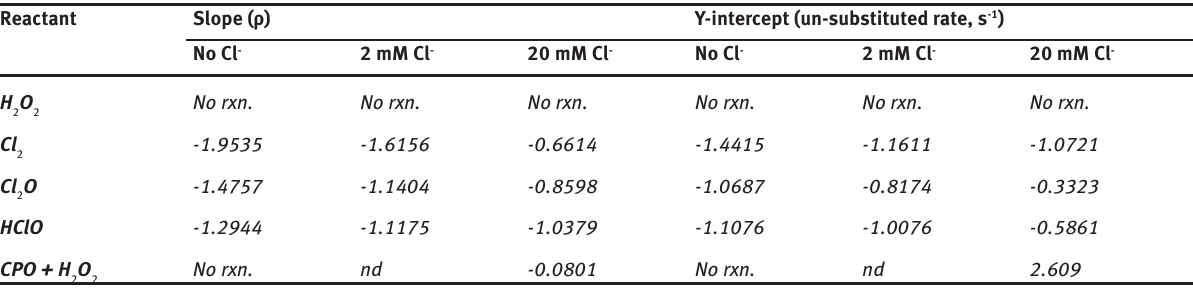
Table 4: A Hammett study of chlorination of p-chloro-, m-bromo-, and p-trifluoromethyl- styrene using various concentrations of chloride ions and with different chlorinating agents (at pH 2.75). Addition of chloride ions and increasing its concentration enhanced reaction rates and alleviated dependency of reaction on electron density at the double